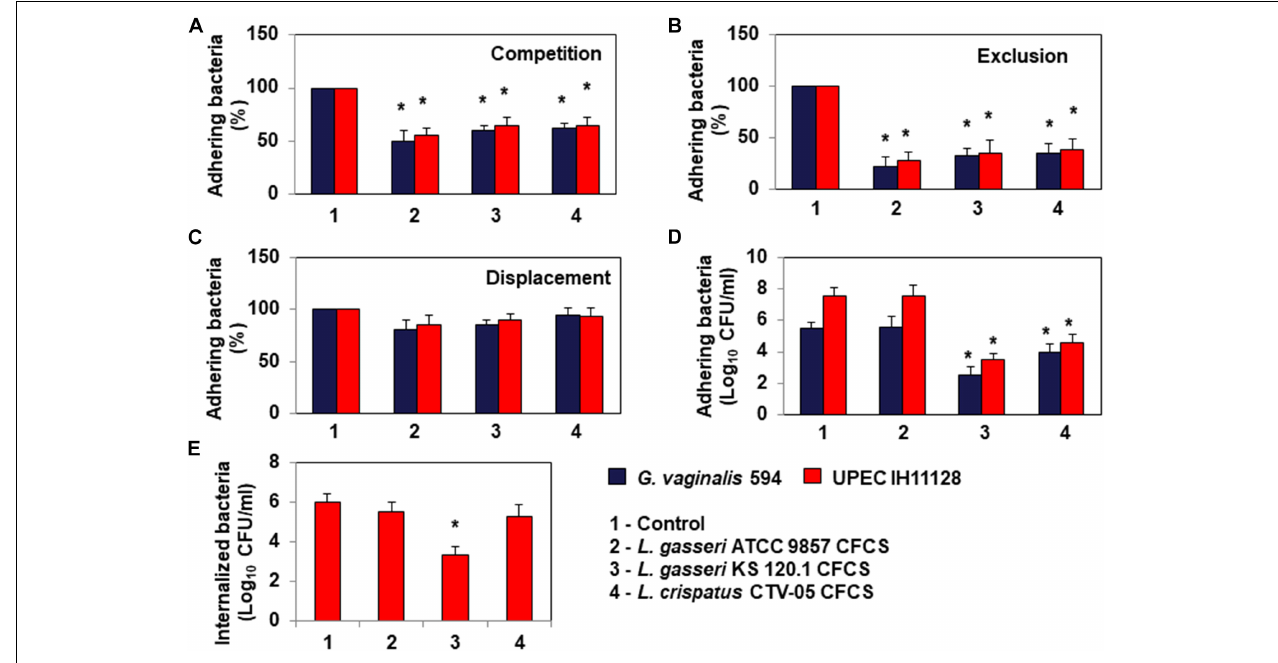
FIGURE 4 | Antagonistic activities of Lactobacillus cells and CFCSs against BV-associated G. vaginalis 594 and recurrent cystitis- and preterm labor-associated E. coli IH11128 adhering to HeLa cells. (A) Inhibition under competition conditions. (B) Inhibition under exclusion conditions. (C) Lack of inhibition under displacement conditions. (D) Killing of pre-adhering UPEC IH11128. (E) Killing of pre-internalized UPEC IH11128. In (A–C) , 100% adhesion corresponds to 5.1 ± 0.5 CFU/ml for G. vaginalis 594 and 7.6 ± 0.4 CFU/ml for E. coli IH11128. Competition, exclusion and displacement experimental condition are described in section “Materials and Methods”. Each value shown is the mean ± SD from three experiments. Student t -test, ∗ p < 0.01 compared to